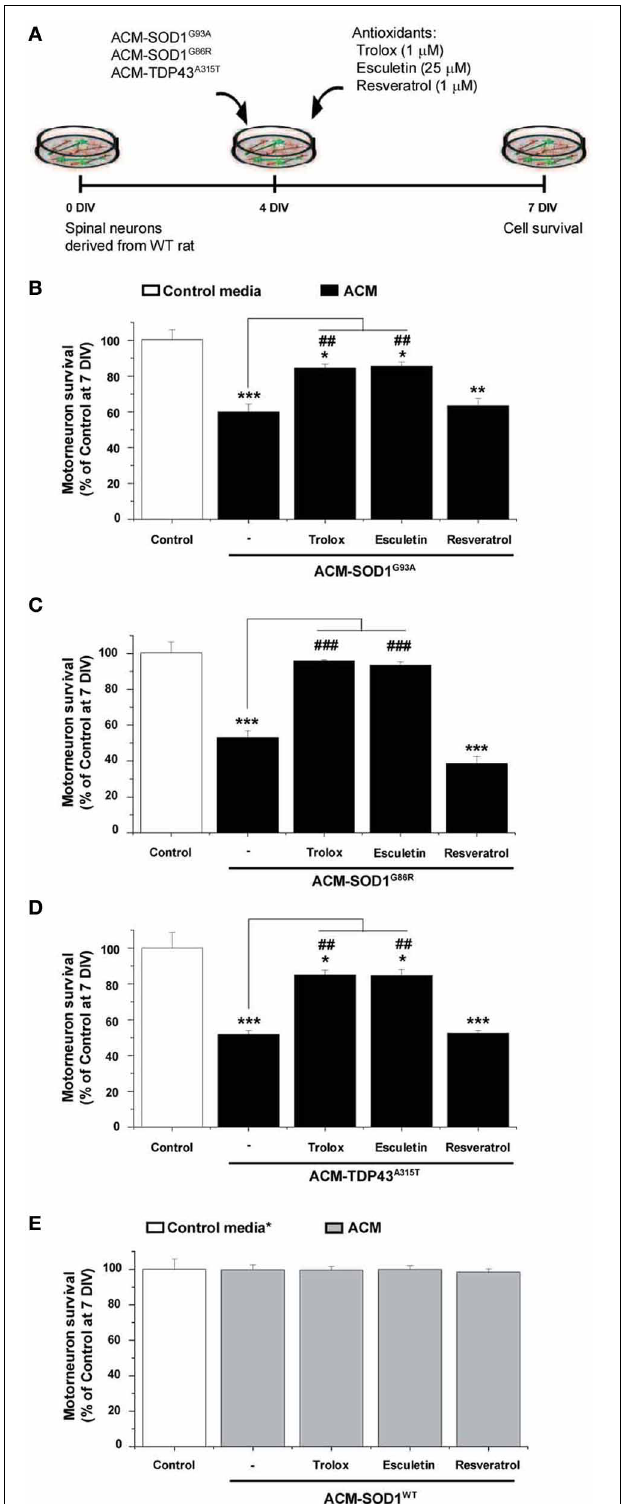
FIGURE 3 | Anti-oxidants Trolox and esculetin prevent motoneurons death induced by ACM-SOD1 G93A , ACM-SOD1 G86R , and ACM-TDP43 A315T . (A) Flow diagram of experiment. ACMs were applied